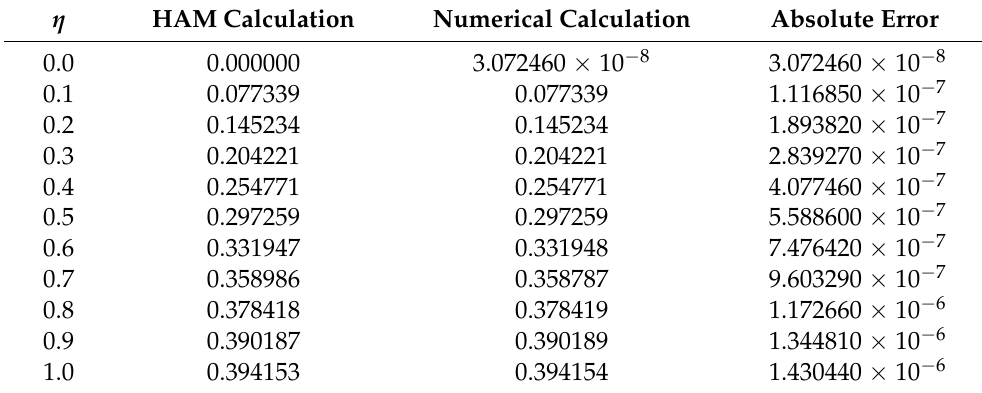
Table 2. Comparison between the analytical (HAM) and numerical results for K ( η ) .